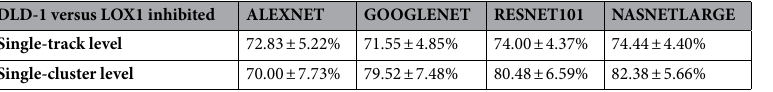
Table 1. Accuracy values of classification using four deep learning network and SVM classification